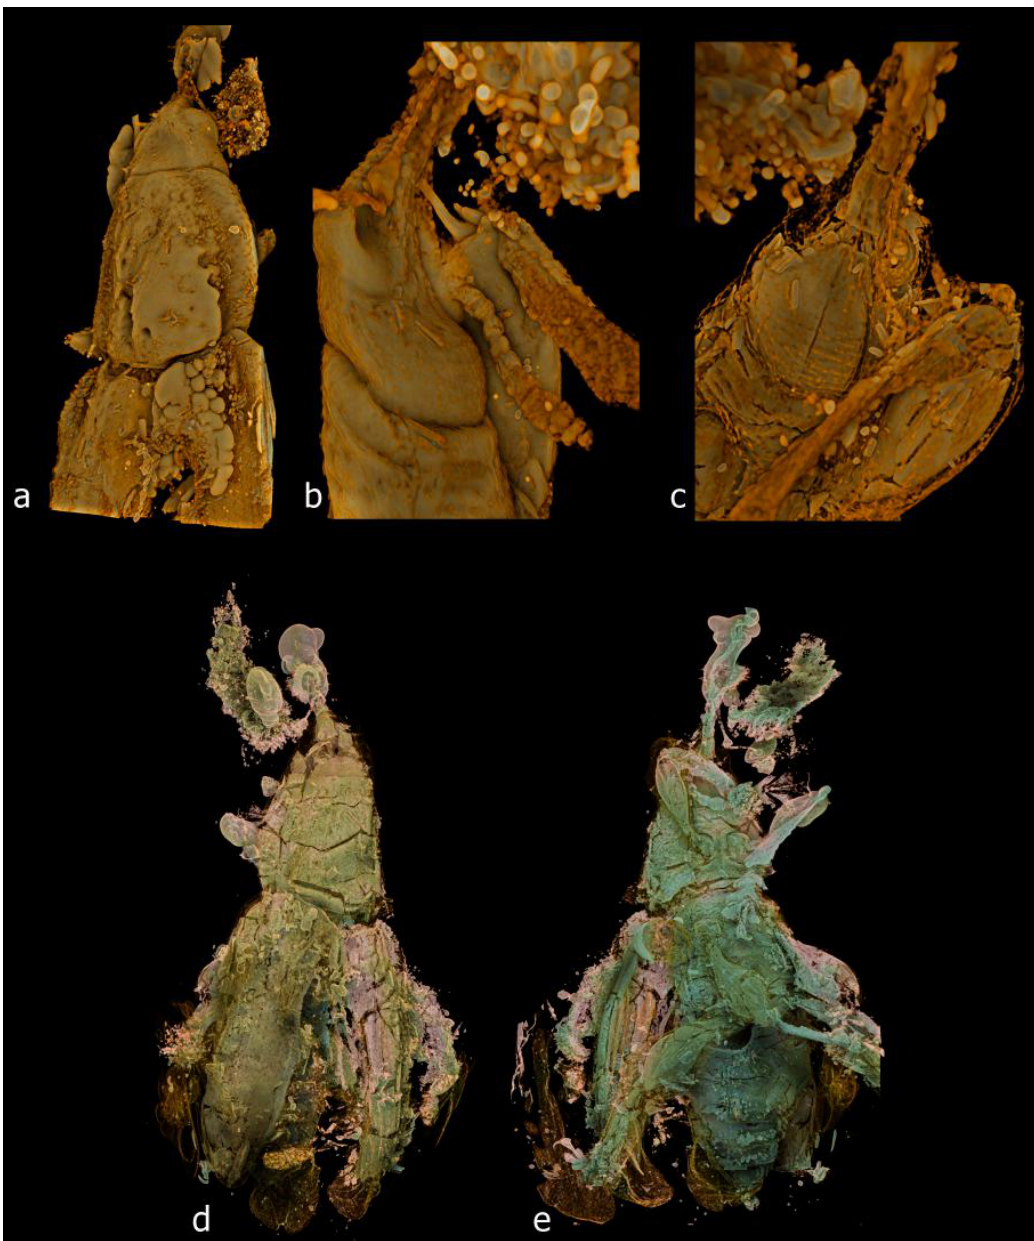
Figure 37. Petalotarsus oxycorynoides sp. n., holotype. Habitus and detail images extracted from micro-CT scanning reconstruction (see also Video S3). Head and pronotum, dorsal ( a ); same, lateral, showing antenna ( b ); same, ventral ( c ); habitus, dorsal ( d ); habitus, ventral ( e ). Petalotarsus curculionoides Clarke & Oberprieler, sp. n. (Figures 38 and 39) Description. Size. Length 4.1–4.4 mm, width 1.6–1.7 mm. Head transverse, weakly constricted behind eyes. Eyes large, elongate, subglobular, somewhat compressed, strongly protruding, forehead between them flat, triangular. Rostrum as long as pronotum, slightly curved; antennal insertions in middle of rostral length, in front of them with lateral row of 7–10 long, erect setae. Antennae moderately long; scapes thin, gradually inflated in distal third; funicles with segment 1 elongate, thick, 2 slightly shorter and thinner, 3–5 progressively shorter and thicker, 6 and 7 as thick as club; clubs with segment 4 long, thin, narrowly obconical, longer than 3. Mouthparts . Mandibles obscured by fine debris, dentition evidently weak; tips of labial palps visible. Thorax . Prothorax slightly proclinate. Pronotum narrowly roundly trapezoidal, longer than broad at base, laterally